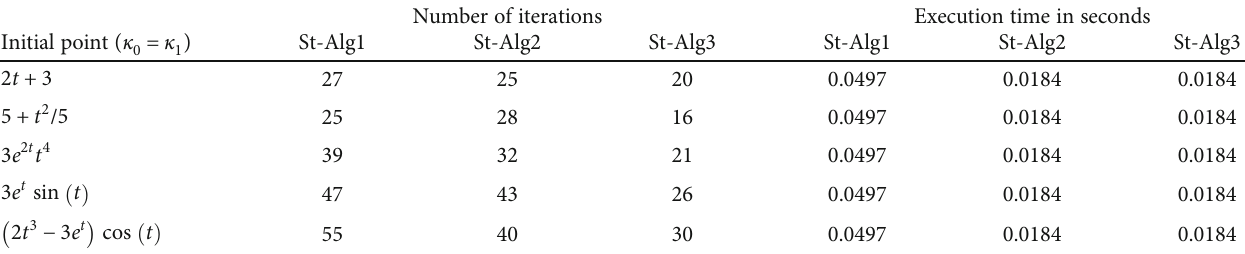
Table 1: Numerical computational results of Algorithm 1:, Algorithm 2:, and Algorithm